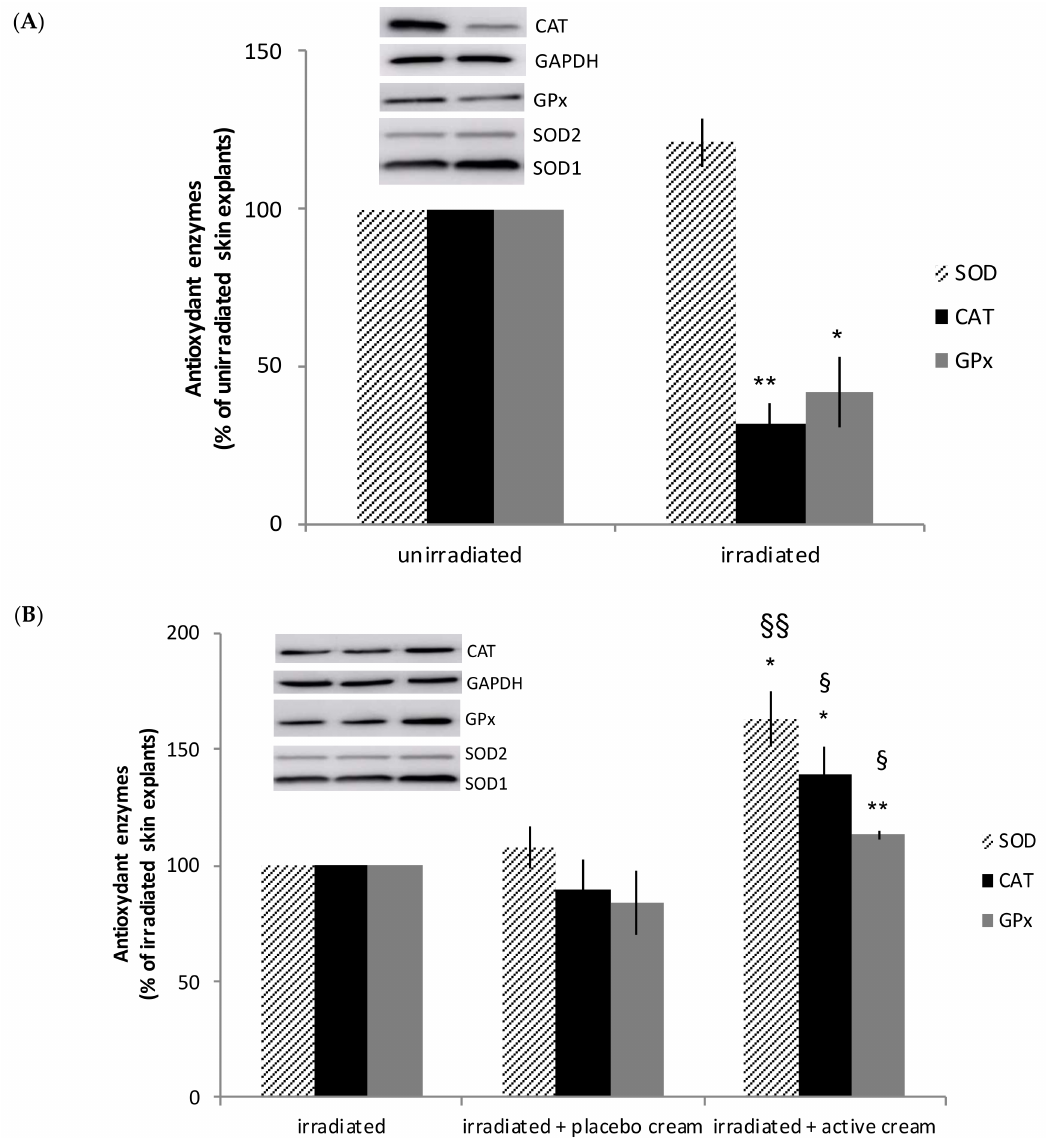
Figure 4. Influence of melon concentrate application on the antioxidant enzymes level after irradiation of human skin explants. Quantification was made after standardizing within membranes by expressing the density of the band of superoxide dismutase (SOD), catalase (CAT), and glutathione peroxidase (GPx) relative to that of glyceraldehyde 3-phosphate dehydrogenase (GAPDH) in the same lane. Results are then expressed as ( A ) relative change from un-irradiated skin explants band intensity and ( B ) relative change from irradiated skin explants band intensity. ( A ) ** p < 0.01 and * p < 0.05 compared with unirradiated skin explants. ( B ) §§ p < 0.01 and § p < 0.05 compared with irradiated skin explants, ** p < 0.01 and * p < 0.05 effect of melon concentrate treatment compared with the irradiated + placebo cream